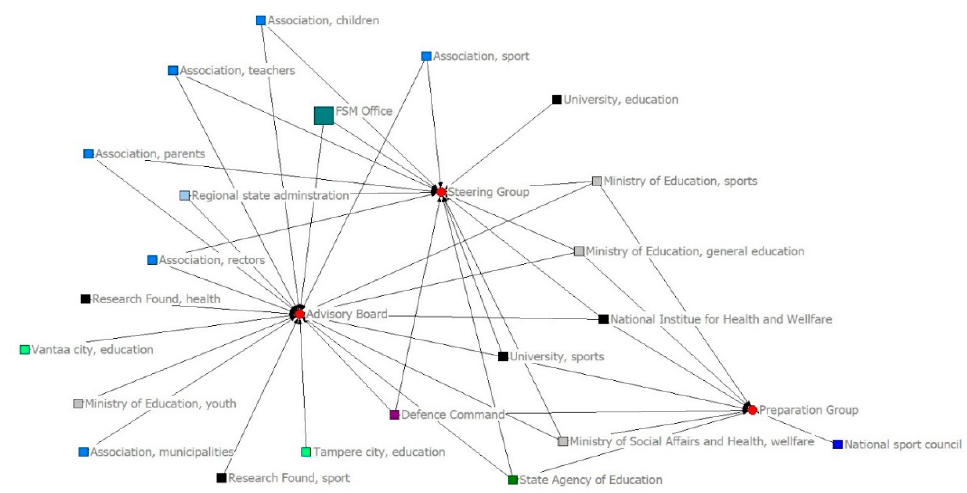
Figure 3. FSM program’s governance network in the first period